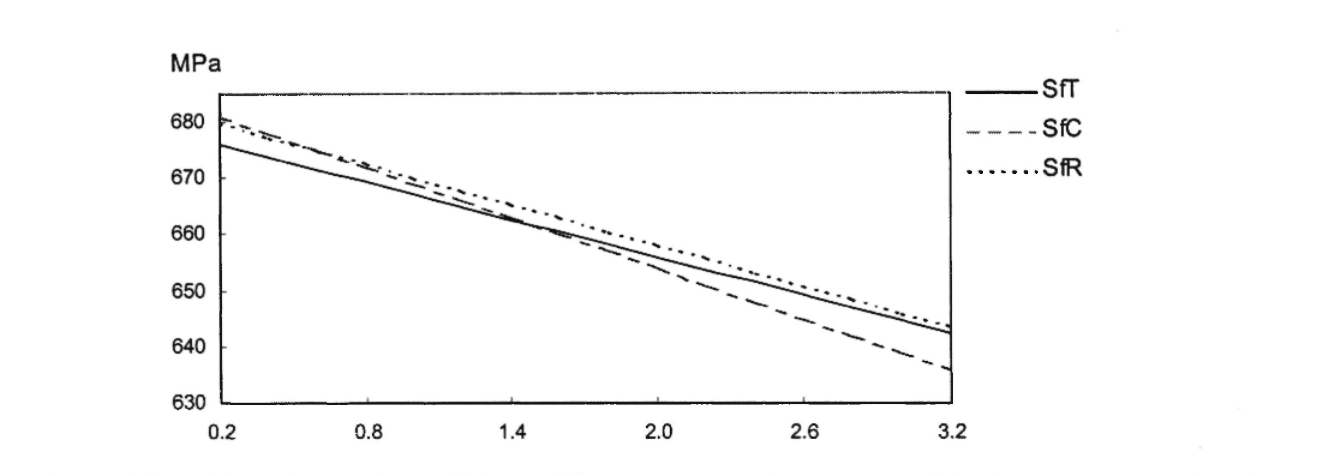
Fig. 7: Effect of thermal expansion coefficients of fiber on maximum absolute stress of fiber for composites reinforced with a transversely isotropic fiber